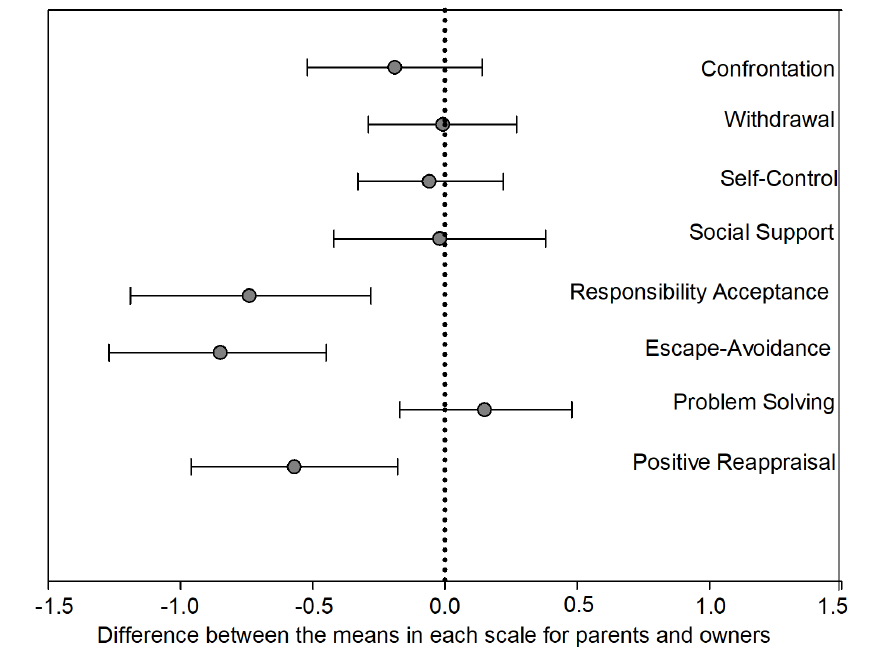
Figure 1. Graph showing the difference between the means in each scale for parents and owners, with a 95% confidence interval